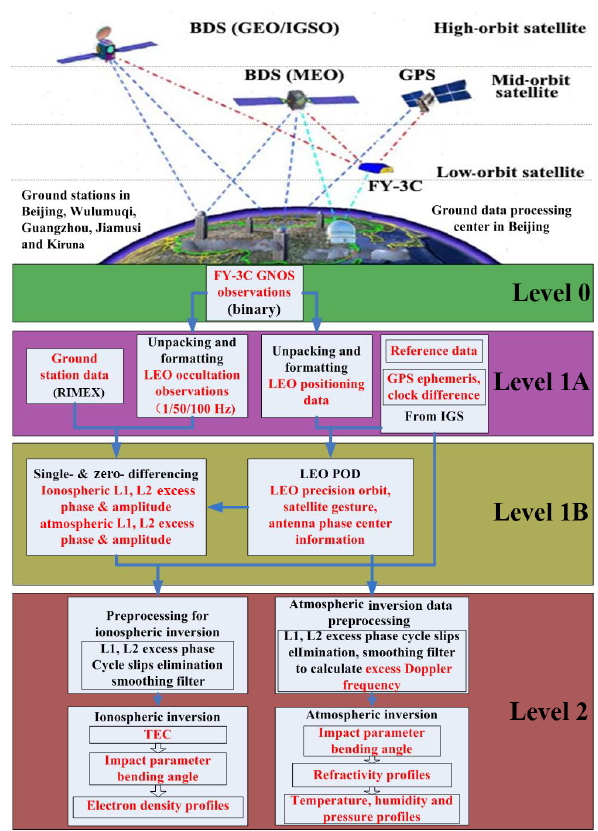
Figure 3. Overview diagram of the elements of the FY-3C GNOS mission and its data processing and data product levels, from raw data (Level 0) down to retrieved atmospheric and ionospheric pro- files (Level